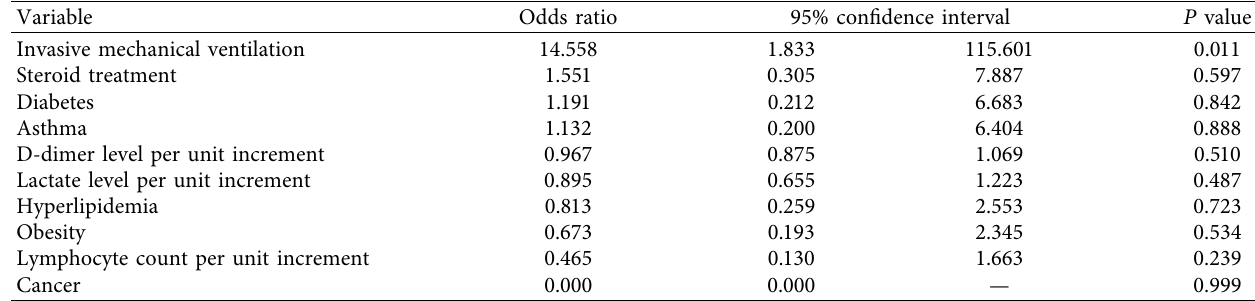
Table 2: Multivariable logistic regression analysis for the risk factors of pulmonary barotrauma. Variables entered in the model are obesity,